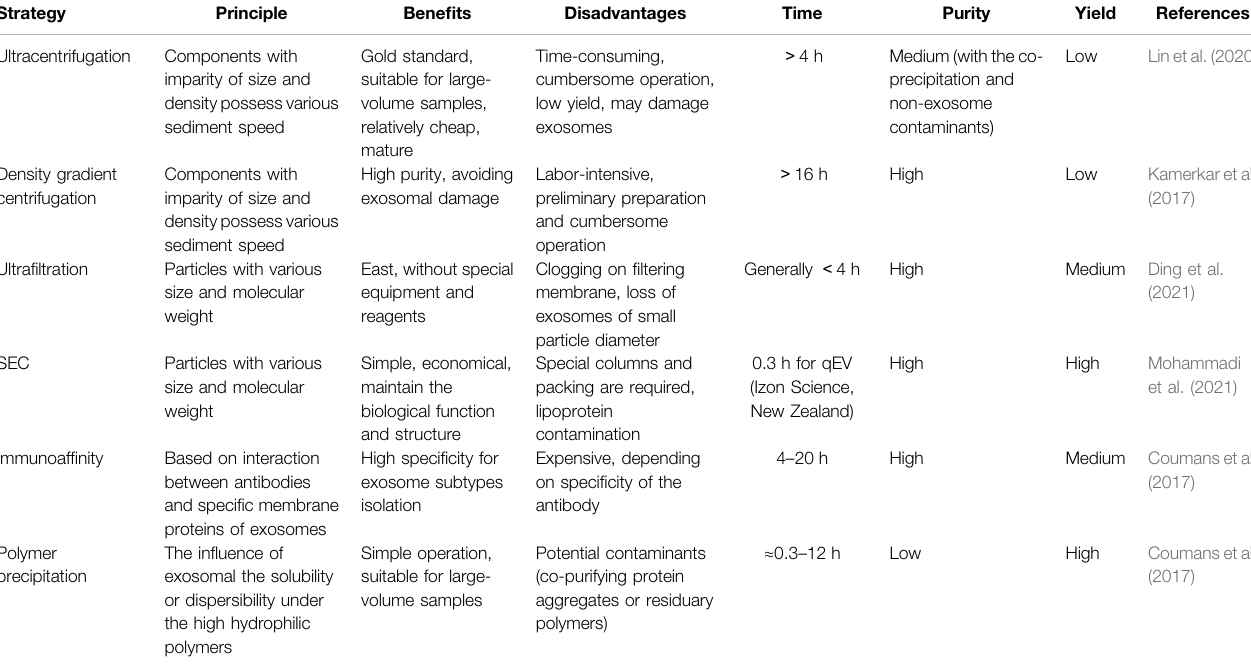
TABLE 1 | Comparison of common exosomes isolation methods and their bene fi ts/disadvantages.